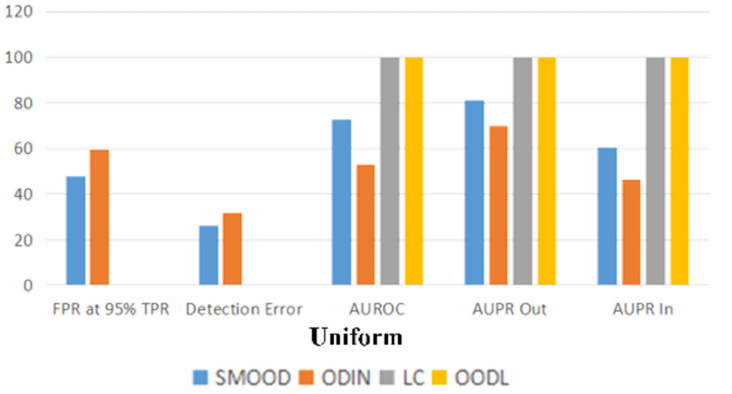
Figure 6. Comparison of results. The ID data are CIFAR-100, the OOD data are SVHN, Gaussian, and Uniform, and the model is